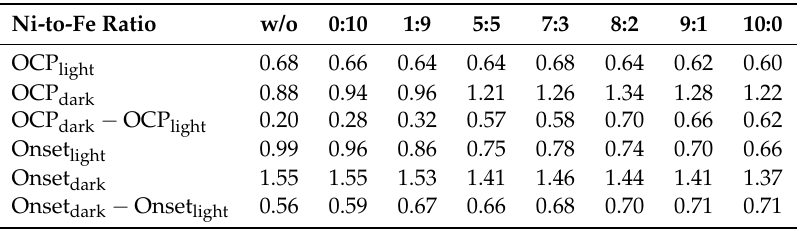
Table 3. Photovoltages extracted from J–V curves (Onset dark − Onset light ) compared with that extracted from open-circuit potentials open-circuit potentials (OCP) (OCP dark − OCP light ). All potentials are in unit of V vs. RHE. All photovoltages are in unit of